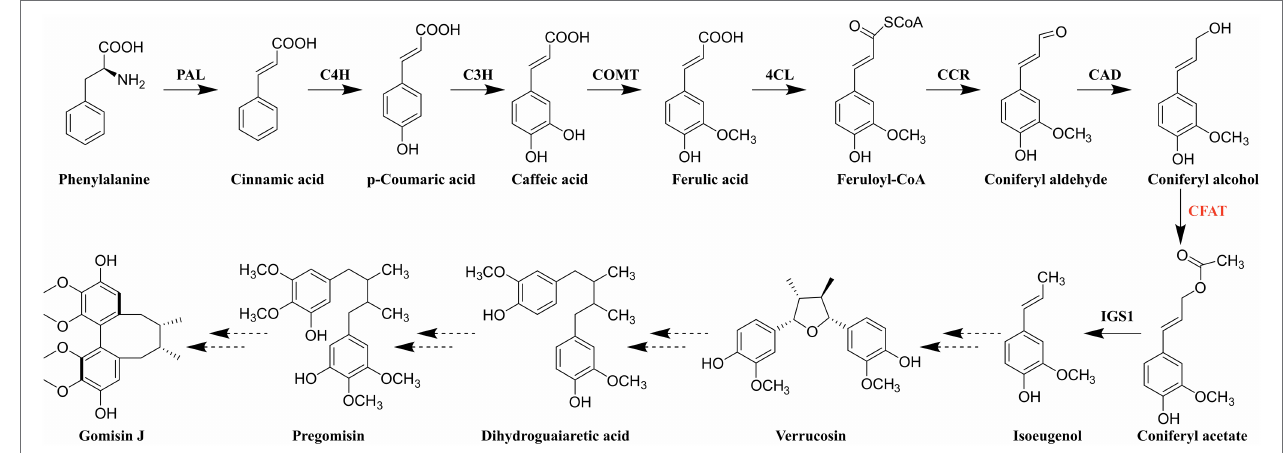
FIGURE 1 | Biosynthetic pathway of dibenzocyclooctadiene lignans. PAL: phenylalanine ammonia-lyase; C4H: cinnamate-4-hydroxylase; C3H: coumarate-3- hydroxylase; COMT: caffeic acid O-methyltransferase; 4CL: 4-hydroxycinnamate CoA ligase; CCR: cinnamoyl-CoA reductase; CAD: cinnamyl alcohol dehydrogenase; CFAT: coniferyl alcohol acyltransferase; and IGS1: isoeugenol synthase